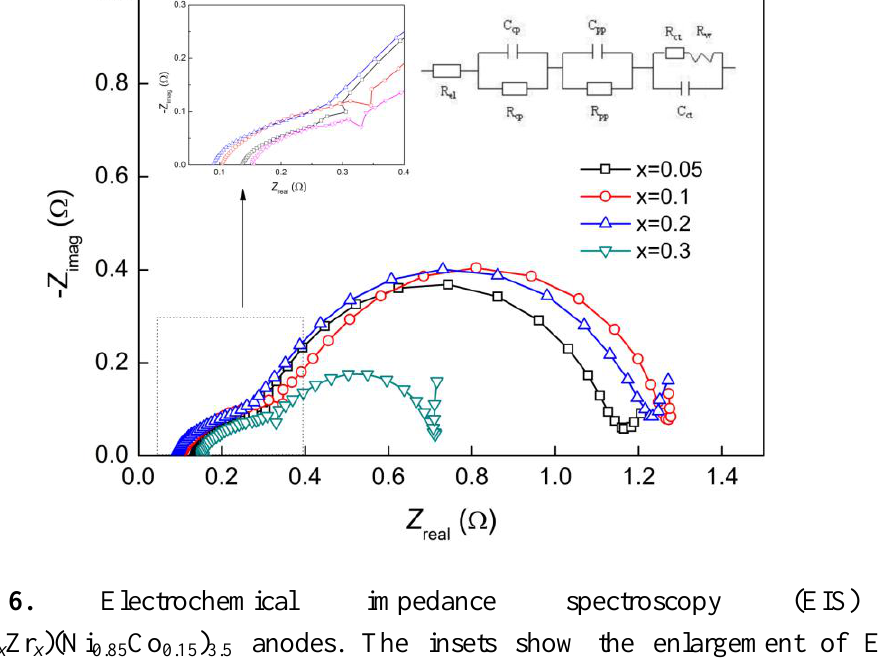
Figure 6. Electrochemical impedance spectroscopy (EIS) of La (Mg Zr )(Ni Co ) anodes. The insets show the enlargement of EIS in 0.7 0.3– x x 0.85 0.15 3.5 high-frequency region and an equivalent